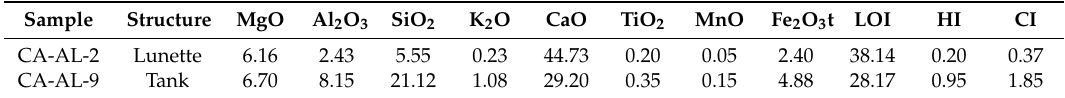
Table 2. Semiquantitative results of the major elements of the binder fraction < 2 µ m in powder samples from the lunette of the barrel vault and tank samples determined by X-ray fluorescence, the hydraulicity index (HI), and the cementation index (CI). Chemical results are expressed as oxides in wt%. Iron content is expressed as total Fe 2 O 3 t. LOI: loss on ignition (%).